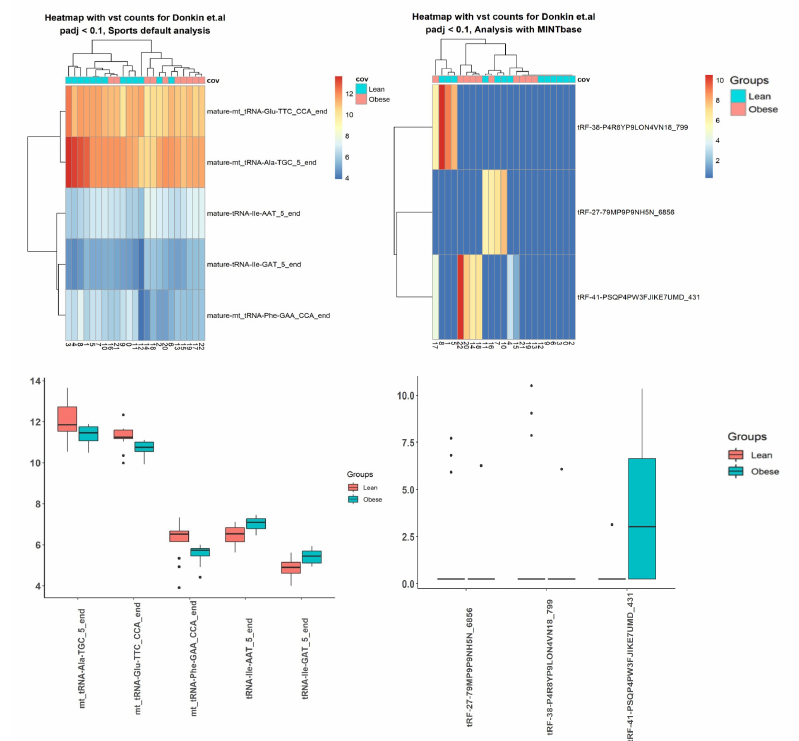
Figure 5. Top differentially expressed tRNA-derived small RNA (tsRNA) using Donkin et al.’s data, processed by SPORTS vs. ITAS-based genome alignment (bowtie + Rsubread + Kallisto)